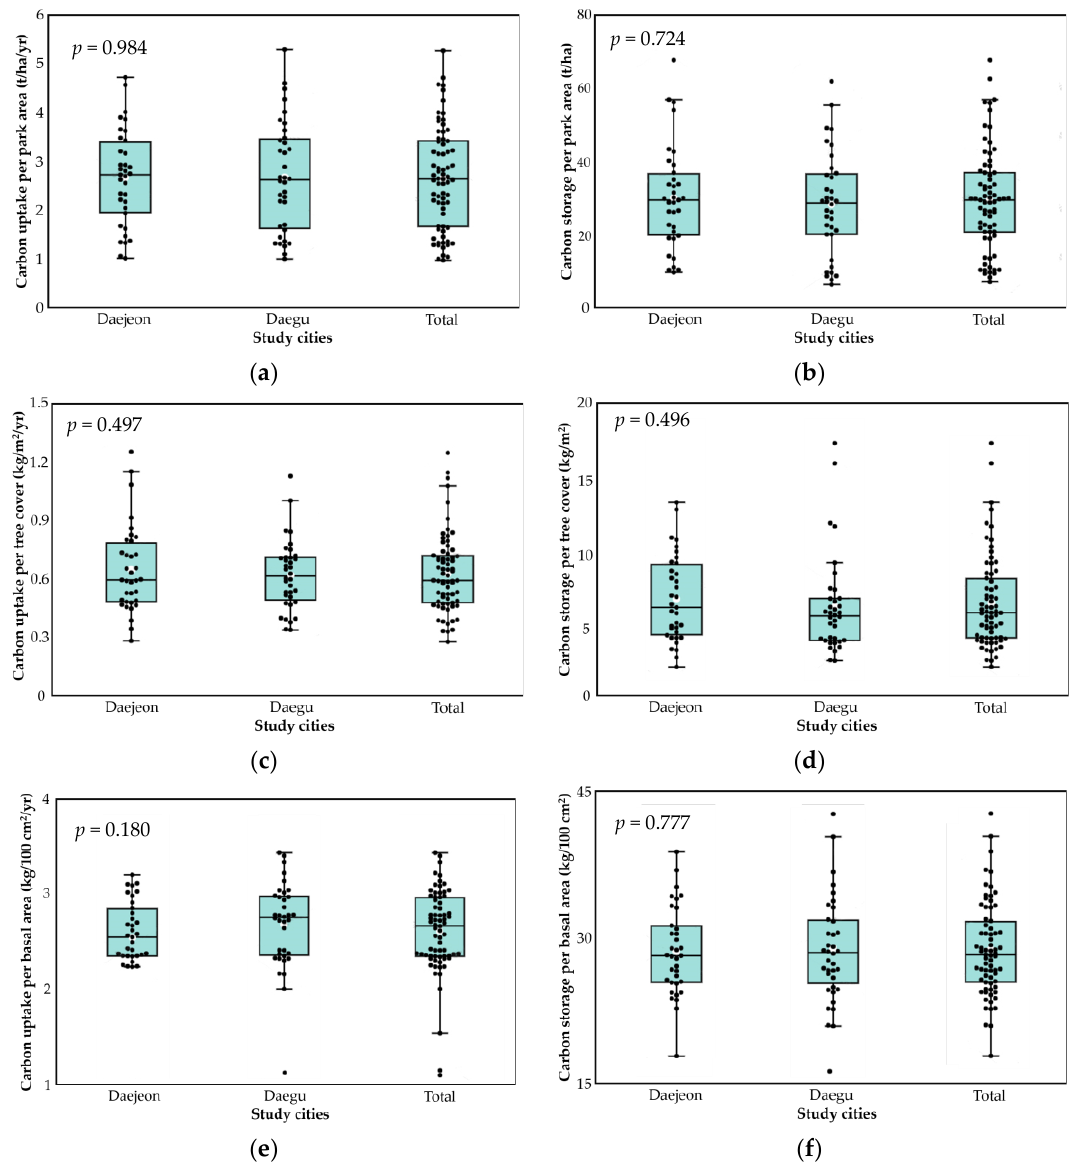
Figure 3. Carbon uptake and storage by trees and shrubs in study parks: ( a ) carbon uptake per park area; ( b ) carbon storage per park area; ( c ) carbon uptake per tree cover; ( d ) carbon storage per tree cover; ( e ) carbon uptake per basal area; ( f ) carbon storage per basal area.